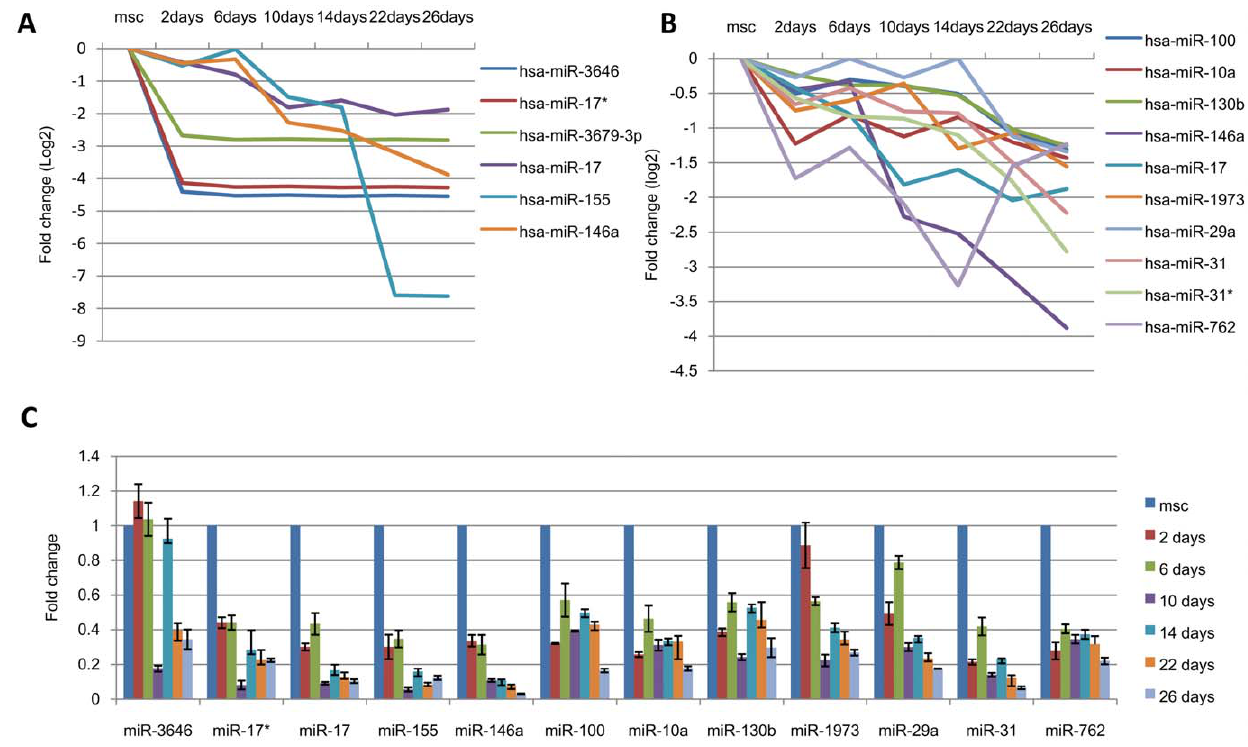
Figure 5. Under-expressed microRNA selection and analysis. A: The expression of six microRNAs that changed $ 4-fold was analyzed by microRNA microarray. B: The expression of the top 10 highly expressed microRNAs (normalized data $ 6) was analyzed by microRNA microarray. C: The expression of the 13 screened under-expressed microRNAs was analyzed by qRT-PCR.